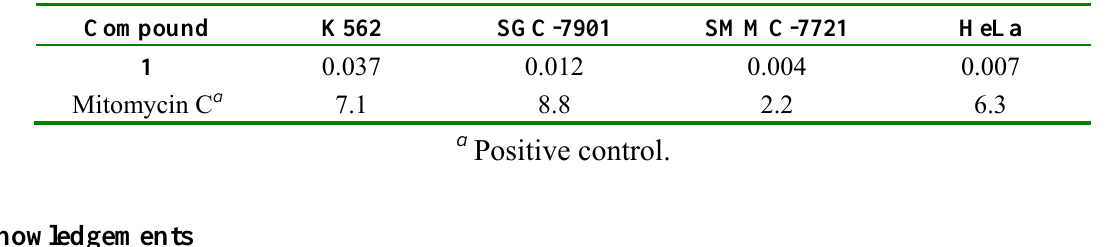
Table 2. In vitro cytotoxicities of compound 1 (IC